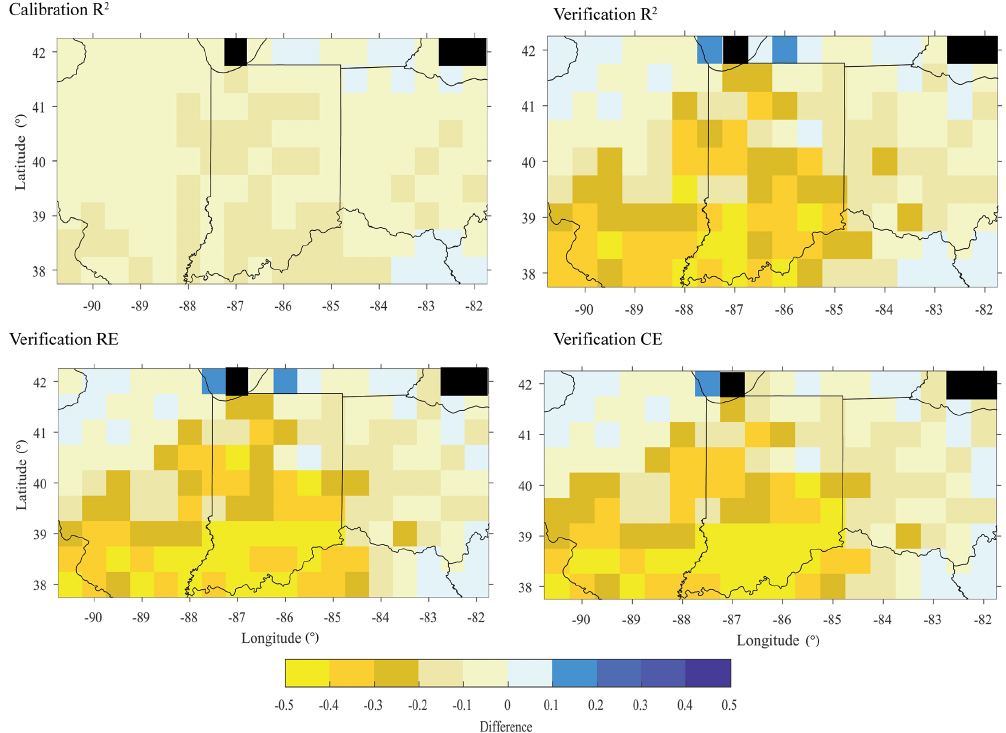
Figure 10. Maps of the difference between the ORV reconstruction when ending the calibration period in 2010 compared to 1980 (i.e., ORV 2010 –ORV 1980 ) for calibration R 2 , verification R 2 , RE, and CE. Black cells represent values over water and therefore no